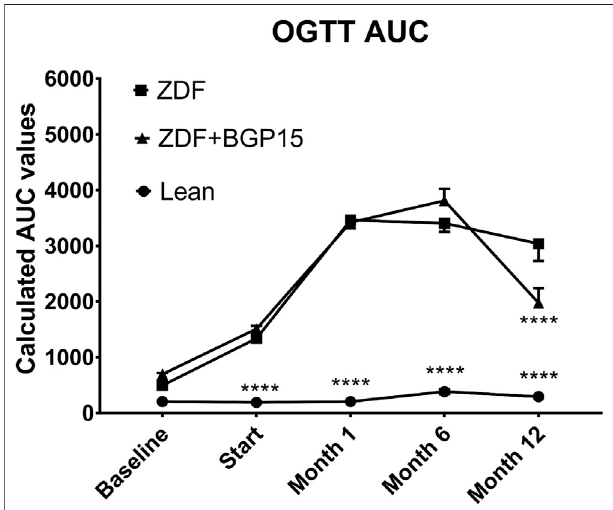
FIGURE 3 | Oral glucose tolerance test (OGTT) area under curve (AUC) values during the study. Data are presented as group means. For a better visibility,standarderrorofthemean(SEM)ofsomedatapointsareplottedonly in one direction, or not plotted at all, if error bars were shorter than the height of the symbol. **** p < 0.0001 compared to ZDF group. Statistical analysis was done using GraphPad Prism: data were analyzed with the two- way analysis of variance (ANOVA) test.